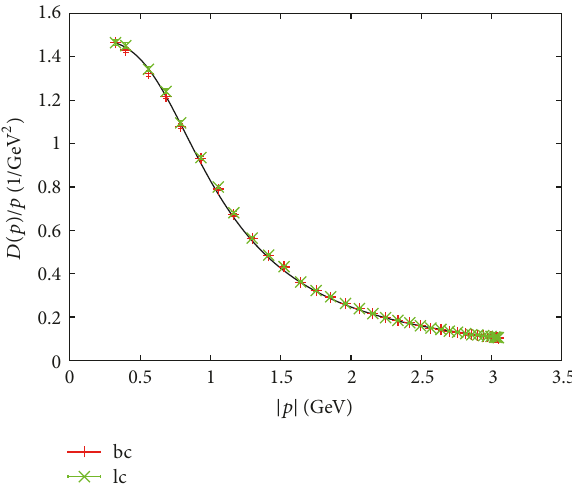
Figure 7: The gluon propagator with the bc and the lc approach from 1000 gauge-fixing attempts. The solid line is a fit to the Gribov formula (20). The choice of Gribov copies apparently makes no visible